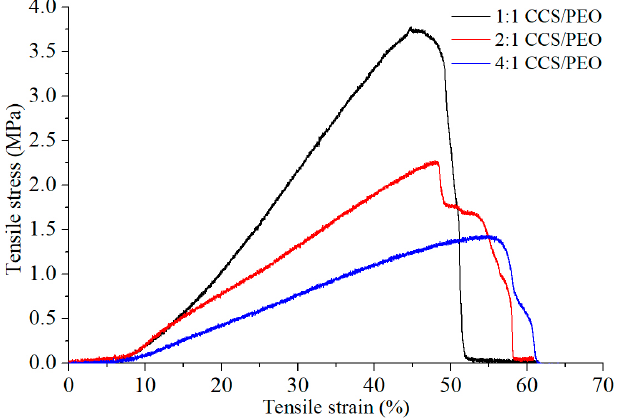
Figure 5. Stress–strain curve of the three different ratios of CCS/PEO nanofiber scaffolds.